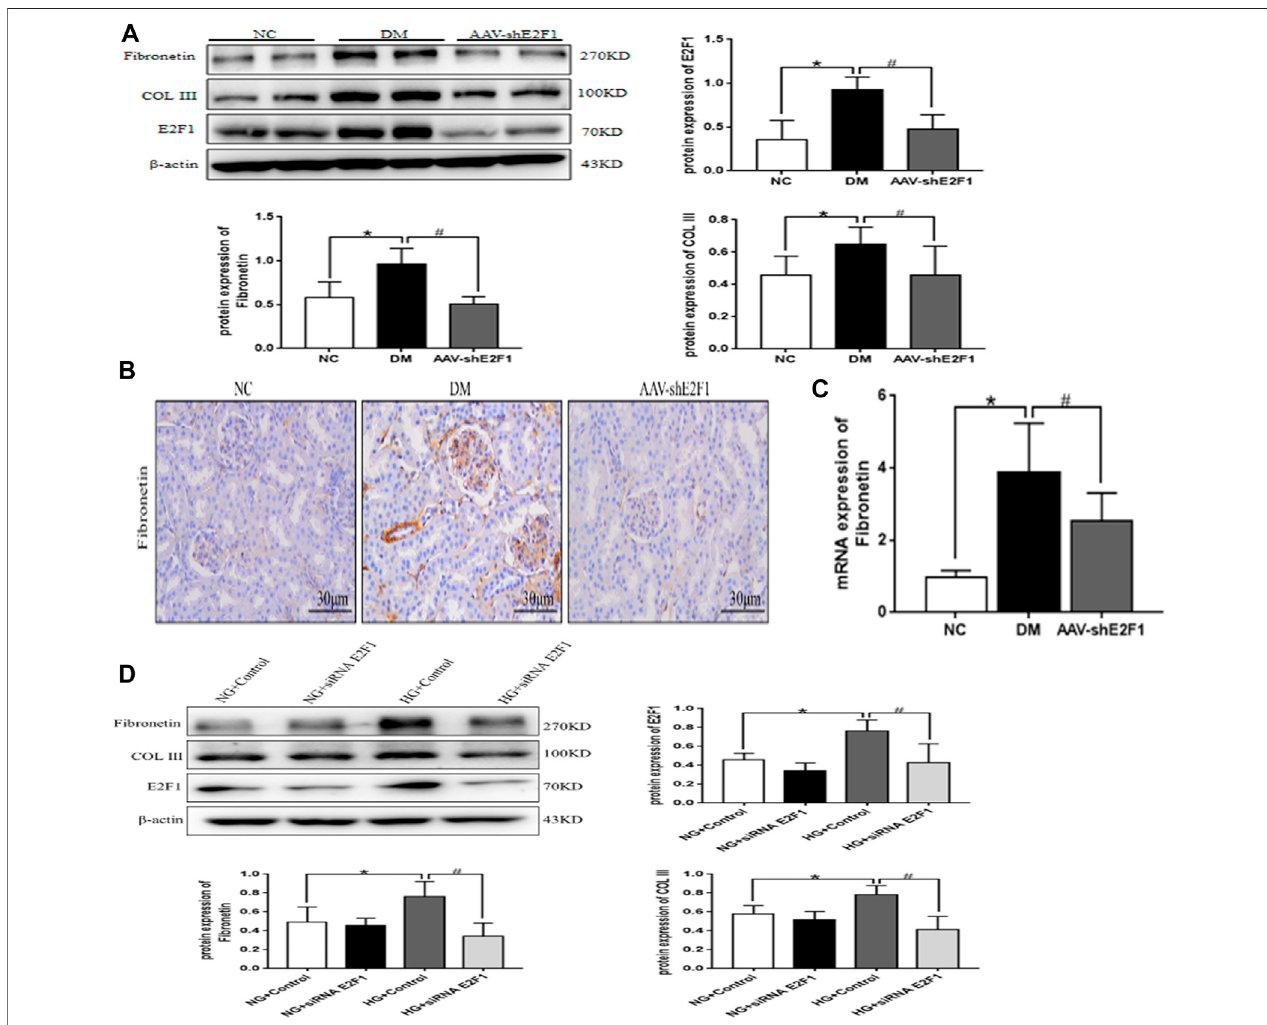
FIGURE 5 | High-expression of E2F1 promotes the fi brosis of renal tubular epithelial cells in the high-glucose state. (A) Western blot analysis of E2F1, Fibronectin, andCOLIIIintherenalcortexofmiceineachgroup(n=6,* p < 0.05vs.NC, # p < 0.05vs.DM). (B) ImmunohistochemicalstainingofFibronectinintherenalcortexofmice ineach group. (C) Real-time PCRanalysisofFibronectinintherenalcortex ofmiceineach group(n=6,* p < 0.05vs. NC, # p < 0.05vs.DM). (D) Westernblotanalysisof E2F1, Fibronectin, and COL III in mRTECs (n = 3, * p < 0.05 vs. NG + Control, # p < 0.05 vs. HG + Control).